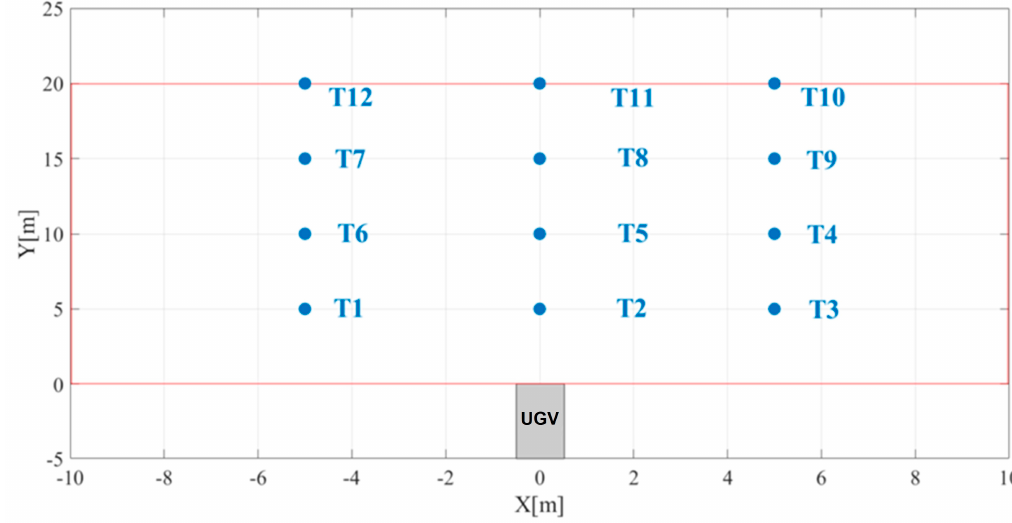
Figure 7. Tag positions with regard to the UGV.